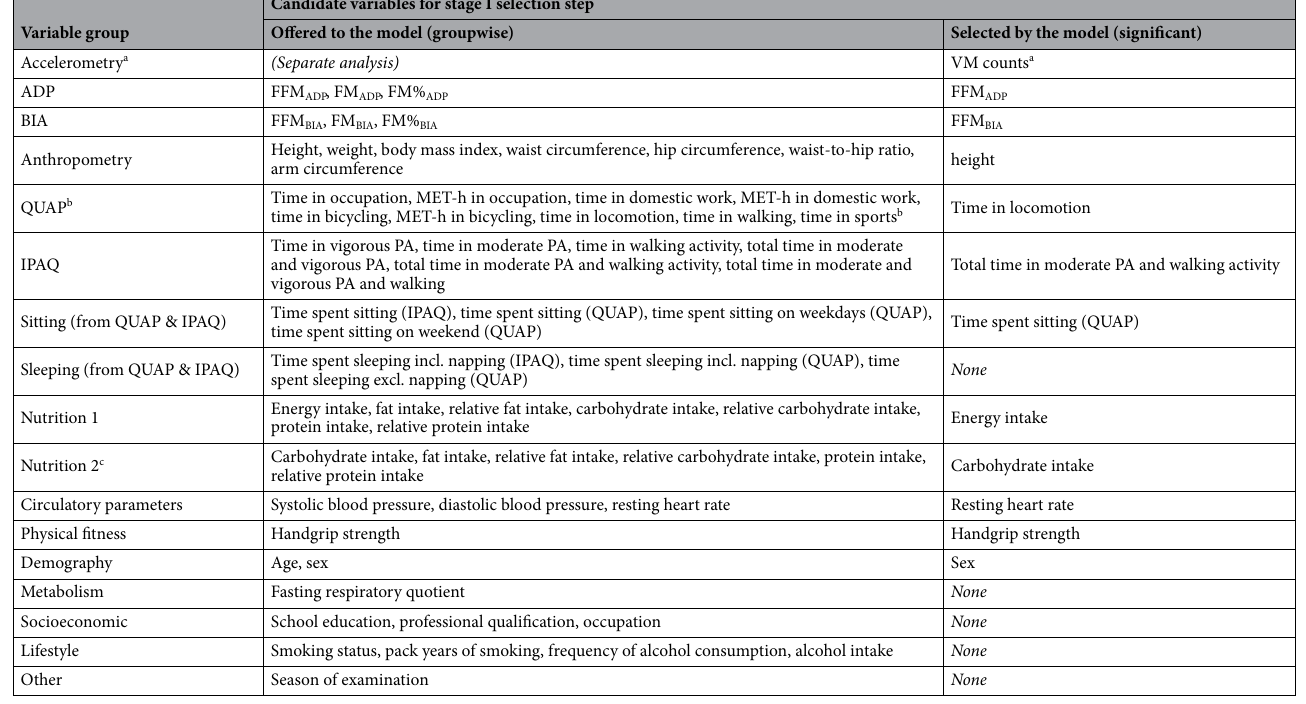
Table 2. Variable groups and its candidate variables after stage I selection using stepwise regression seperately for each group (n = 49). In each group all candidate variables were offered to select significant variables for AEE prediction by stepwise selection regression using p-value limits of 0.05 for the corresponding partial F-statistic for including and retaining variables in the model. a In the accelerometry group, of 15 candidate variables the single parameter VM counts was selected because it explained the highest proportion of variance in AEE (33.8%, similar to Axis 1 counts 34.0%) using linear regression, was frequently used in previous studies 13 , and revealed higher correlations in similar designed studies with higher sample sizes 24 . b In addition, we tested the following combined variables that were calculated as sum of the single variables: total time in locomotion, bicycling, walking, and sports; total time in locomotion, bicycling, walking, sports, and domestic work; total time in locomotion, bicycling, walking, sports, domestic work, and occupation. c We considered two groups for nutrition: the second group does not include energy intake , as this variable is directly related to the aggregated intake of the macronutrients (carbohydrate, protein, and fat). ADP air-displacement plethysmography,